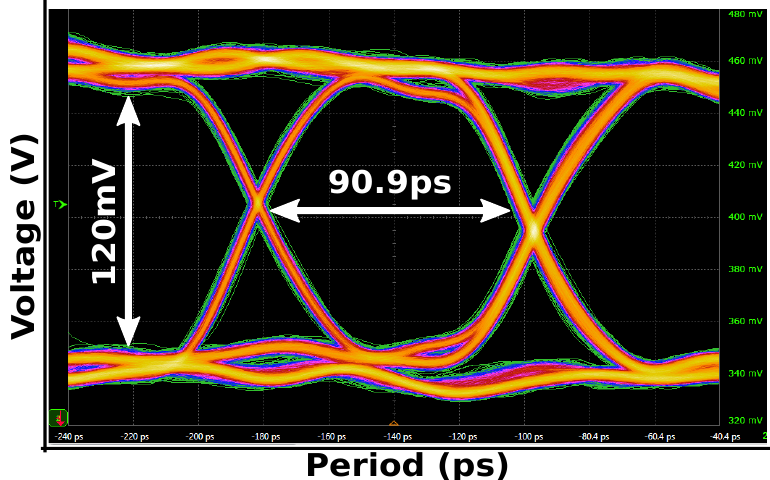
Figure 11. Eye diagram of the comparator output at 11GHz for a coherent Nyquist input frequency.